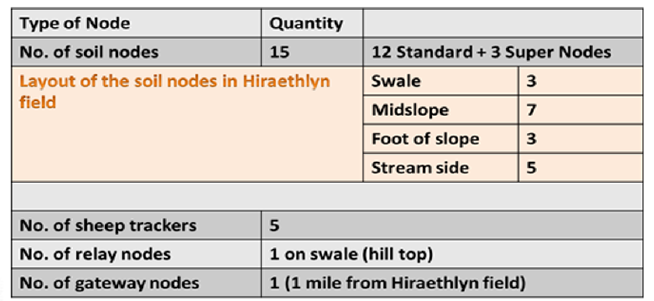
Figure 12. Number of nodes in the field.